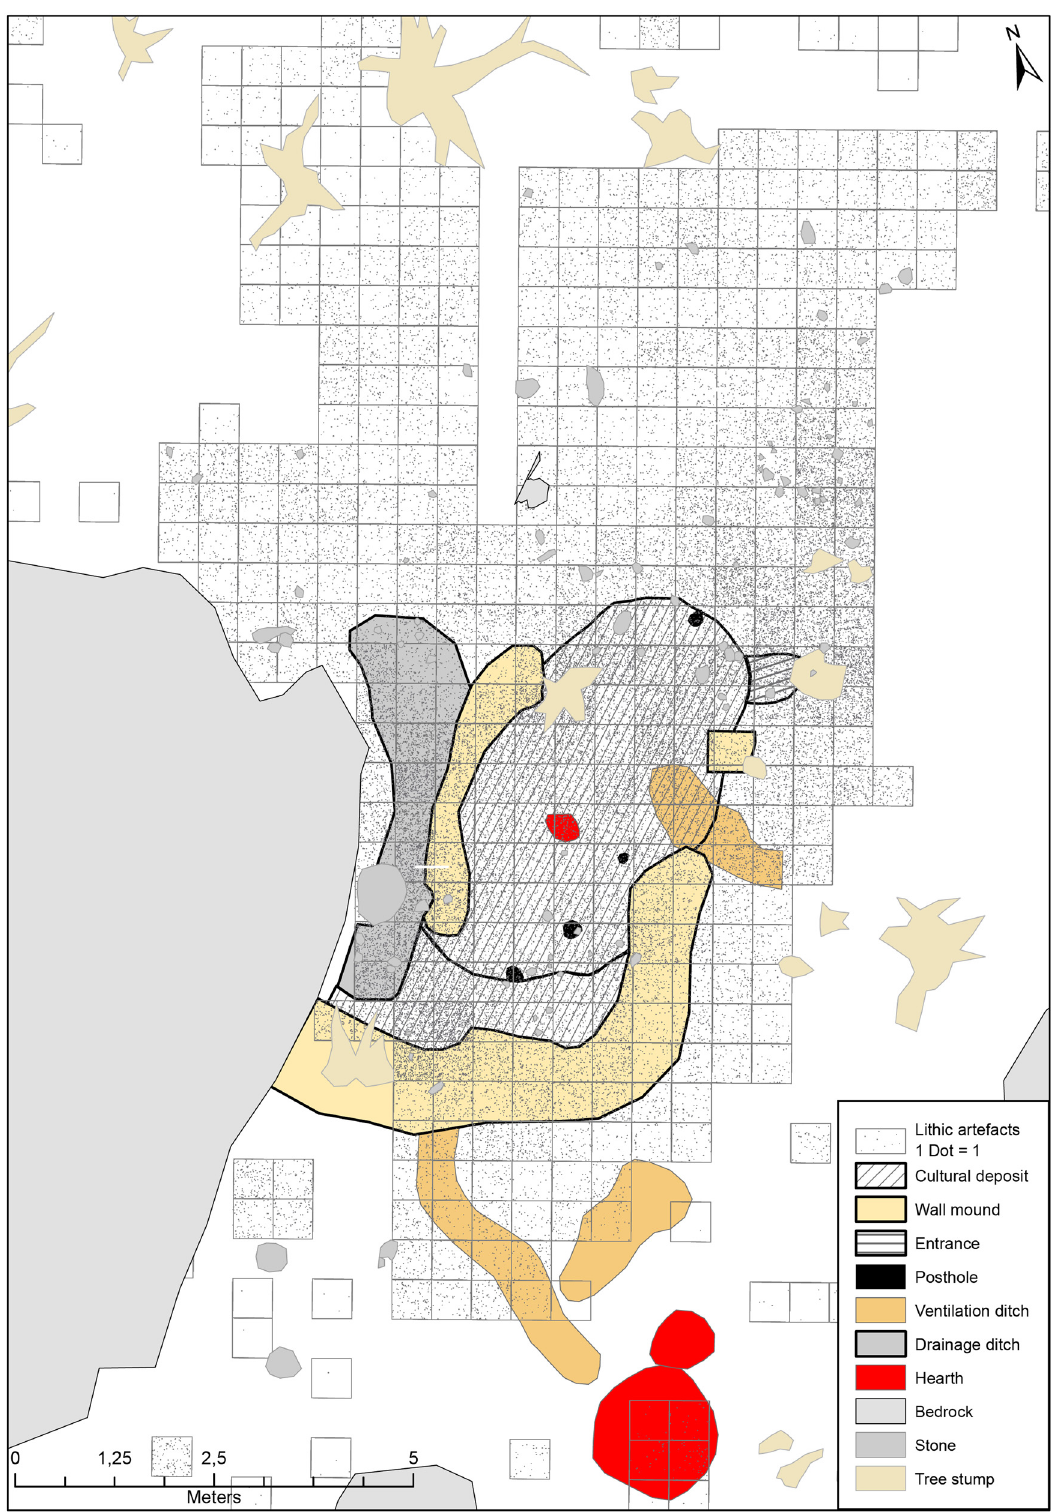
Figure 8: Interpretation of key features and artefact distribution uncovered during the excavation of Site 3 in Havsjødalen. Map: Axel Mjærum,